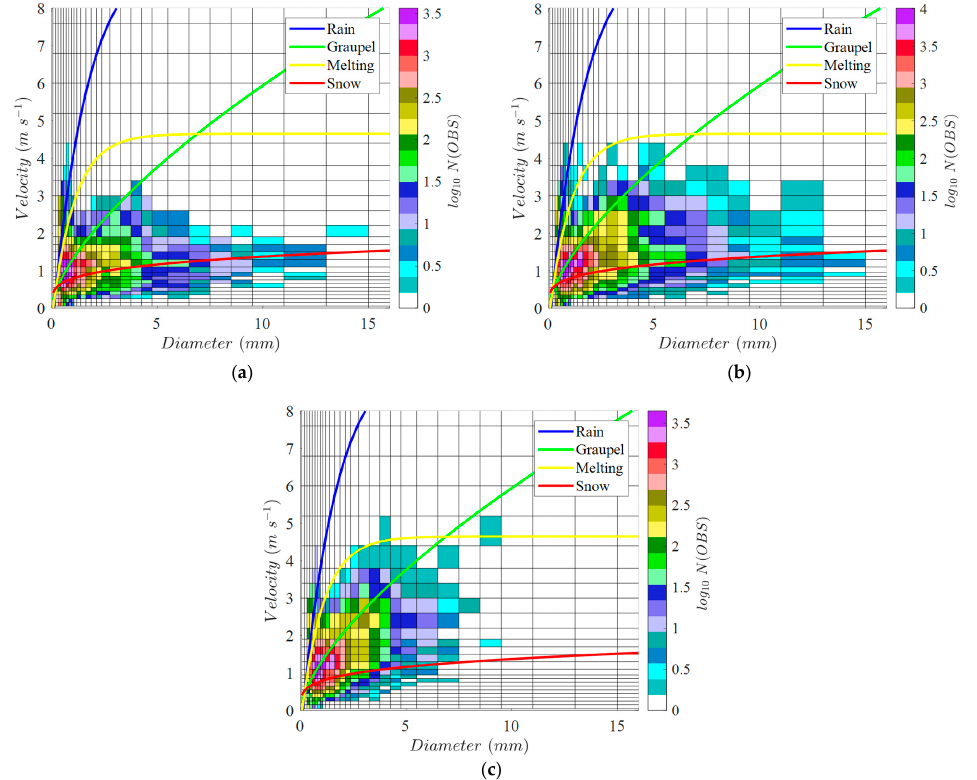
Figure 10. Distribution of particle falling velocity and diameter for three 𝑆𝑅 , where ( a – c ) correspond to 𝑆𝑅 ≤ 0.5 mm/h, 0.5 < 𝑆𝑅 < 2.5 mm/h and 𝑆𝑅 ≥ 2.5 mm/h, respectively. Figure 10a corresponds to 𝑆𝑅 ≤ 0.5 mm/h, indicating that the distribution of falling velocity and diameter of particles coincides with the distribution curve of snow particles. Figure 10b corresponds to 0.5 < 𝑆𝑅 < 2.5 mm/h, indicating that the distribution of falling velocity and diameter of particles has the distribution characteristics of both snow and graupel particles. Figure 10c corresponds to 𝑆𝑅 ≥ 2.5 mm/h, indicating that the distribu- tion of falling velocity and diameter of particles is closer to the distribution characteristics of graupel particles. 4. Discussion In this study, we analyzed snowfall microphysical characteristics based on disdrom- eter measurements obtained in Beijing to further improve the parameterization and esti- mation of winter precipitation in north China. Snow PSDs were fitted to the gamma model with the moment method to calculate the three parameters of Gamma distribution. Compared to the result reported by Brandes et al. [46], the fitted relations for snow are similar, and most values of 𝜇 and 𝛬 are in small regions. The 𝜇 − 𝛬 relationship of wet and dry snow obtained in this study and Pu